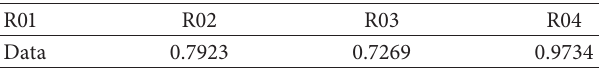
Table 4: Correlation degree of GDP and output value of core layer, outer layer, and related layer of cultural